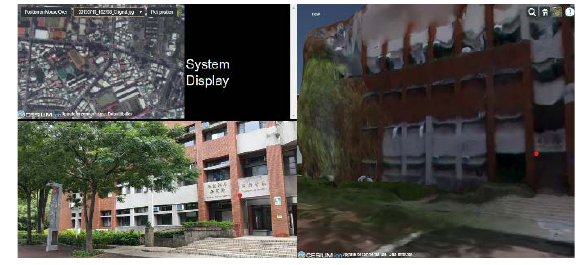
Figure 8. 3D city model in web